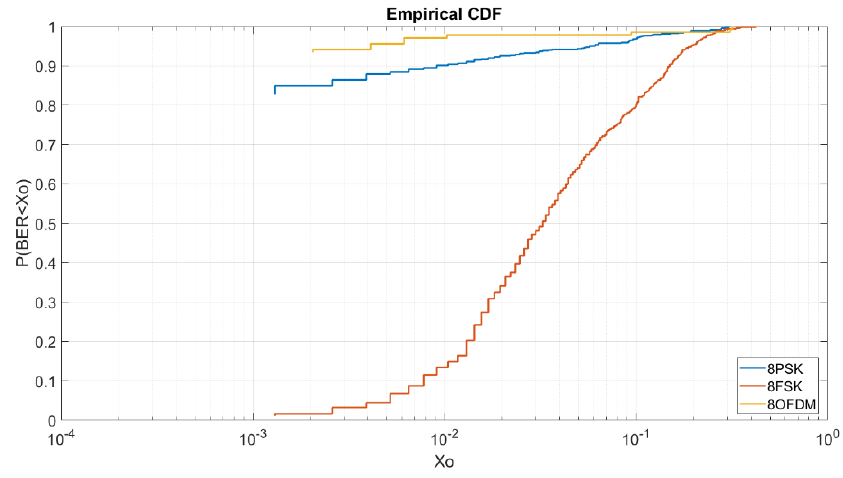
Figure 12. BER vs. E b /N 0 = 8 dB M = 8.